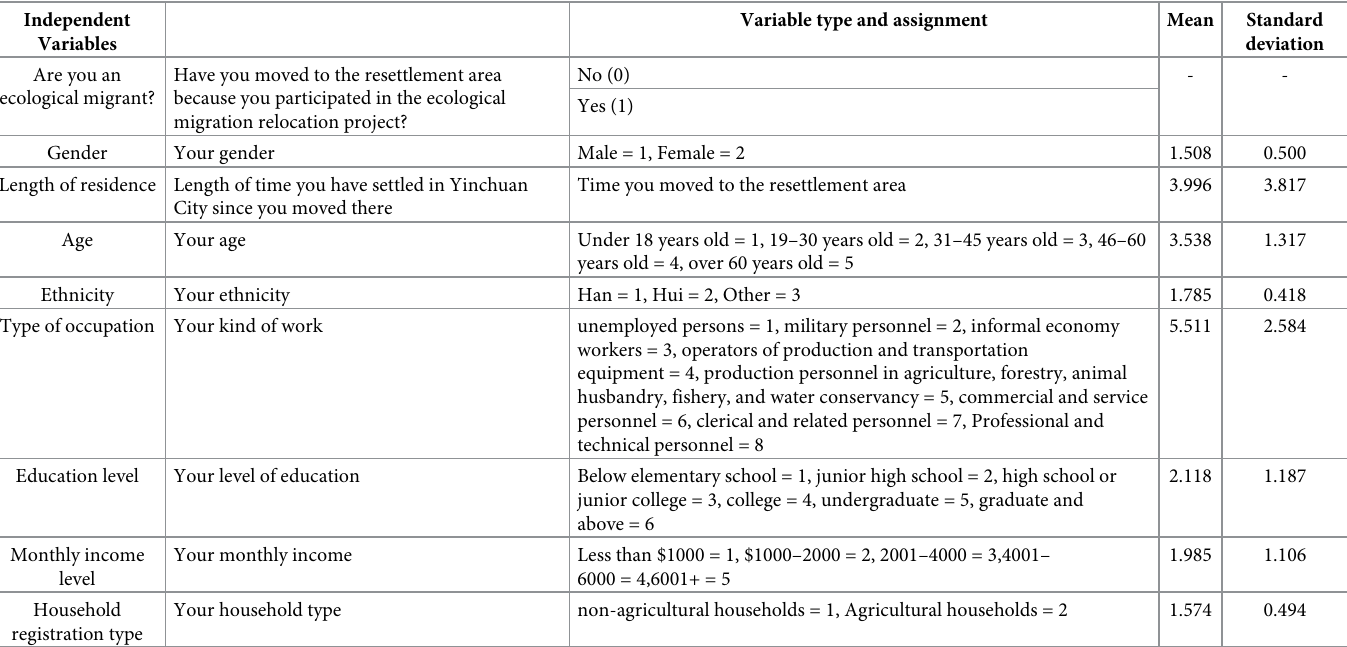
Table 5. Variable selection of influencing factors of social integration of ecological migrants in Yinchuan. Independent Variables